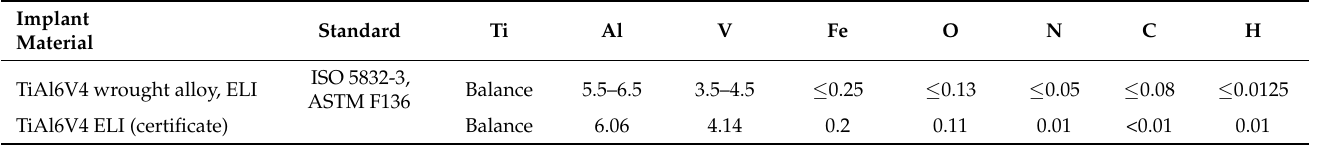
Table 1. Chemical composition of the TiAl6V4 ELI wrought alloy according to the corresponding standard and based on the trader’s inspection certificate (m%).